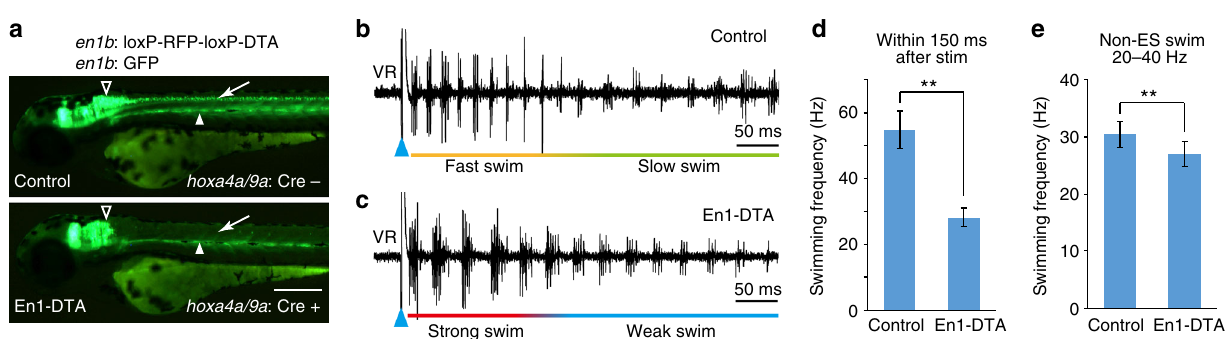
Fig. 1 Firing patterns of V1 neurons in larval zebra fi sh. a A side view of the compound transgenic fi sh of Tg[ en1b :Gal4] and Tg[UAS:Kaede]. The dashed lines indicate boundaries of the spinal cord. Scale bar, 20 μ m. b A schematic illustration of the simultaneous recordings of a V1 neuron (loose-patch) and ventral root (VR). Fictive swimming was elicited by applying brief electrical stimulation near the tail. c An example of the recordings from the fast-type V1 neurons. The blue arrowhead shows the time point of electrical stimulation. In the right panel, the region shadowed in blue in the left panel is enlarged. d An example of the recordings from the slow-type V1 neurons. e Histogram of spike timings of fast-type V1 neurons during fast (50 – 65 Hz) swim (1387 swimming cycles from 29 cells). f Histogram of spike timings of slow-type V1 neurons during slow (25 – 35 Hz) swim (5782 swimming cycles from 10 cells). g Schematic diagram of the Kaede photo-conversion experiment (top). The bottom two panels show the recordings from early-born V1 neurons (red Kaede [shown in magenta], left) and late-born V1 neurons (green Kaede, right). Scale bar, 10 μ m. h Firing probability of early-born V1 neurons (left, n = 25) and late-born V1 neurons (right, n = 22) in each cycle during fast (>50 Hz) and slow (<40 Hz) swim. Each colored circle represents each recorded cell. i Classi fi cation of the recorded V1 neurons. Out of the 25 early-born V1 neurons, n = 23 for fast-type and n = 2 for hybrid-type. Out of the 22 late-born V1 neurons, n = 9 for fast-type, n = 10 for slow-type, and n = 3 for hybrid-type. If the value of the fi ring probability during fast swim was more than double that during slow swim, the cell was considered a fast-type (and vice versa). If the difference was within the doubled value, the cell was considered a hybrid-type